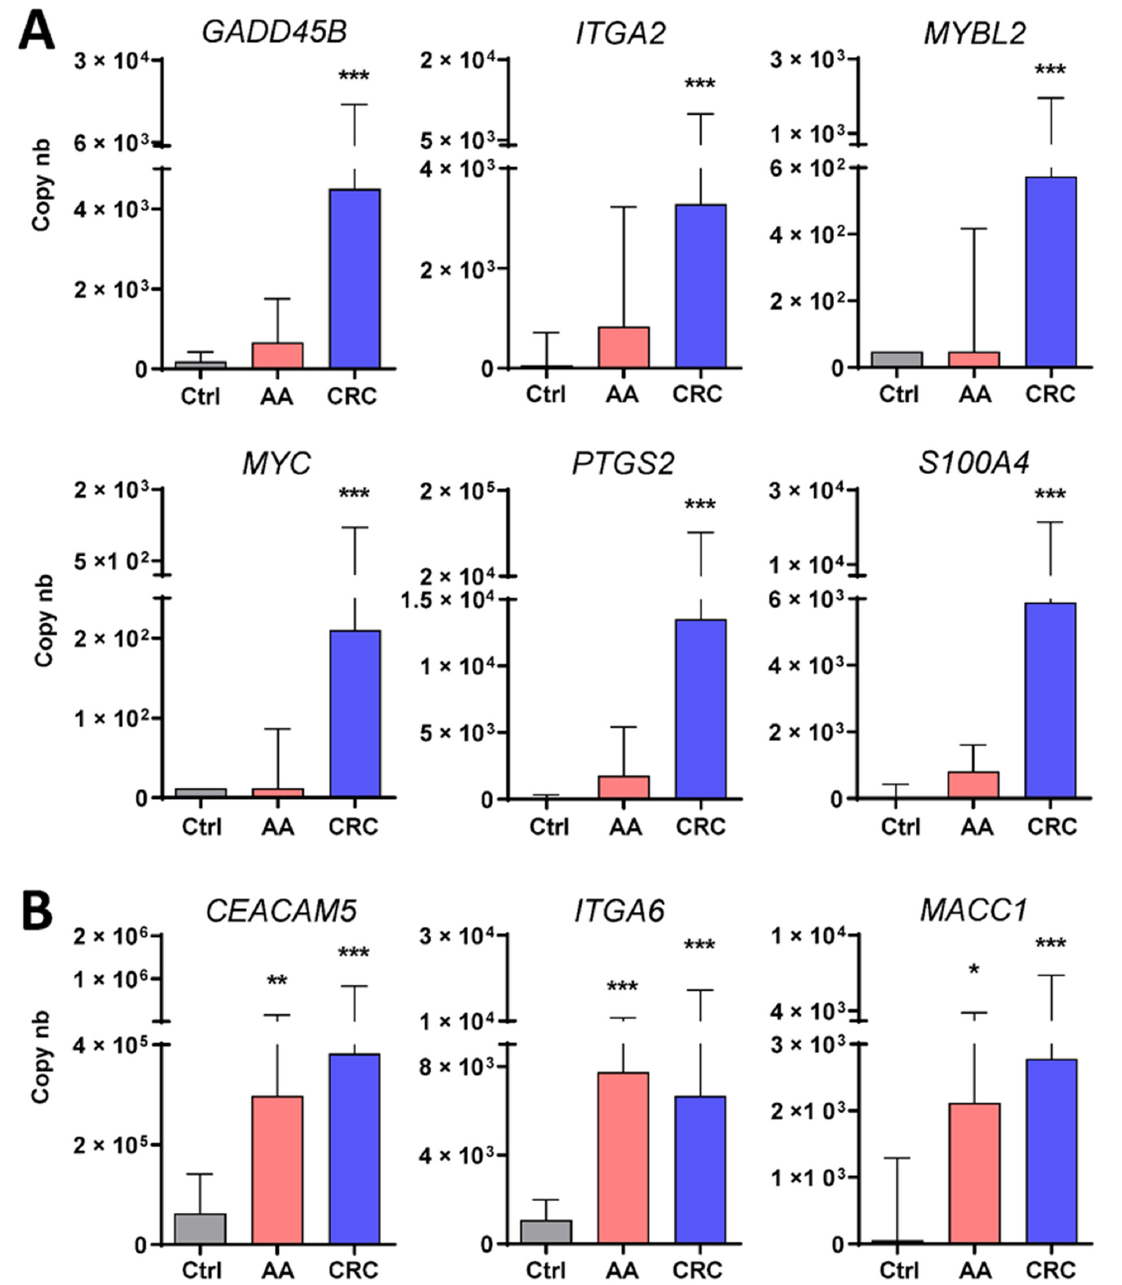
Figure 1. Detection and analysis of selected mRNA targets found to be overrepresented in stool samples of patients with colorectal cancer (CRC) stages I-III ( A ) or advanced adenomas (AA) ( B ). A significant increase was observed for the targets GADD45B , ITGA2 , MYBL2 , MYC , PTGS2 and S100A4 in CRC stages I-III as compared to controls (Ctrl) while for three of